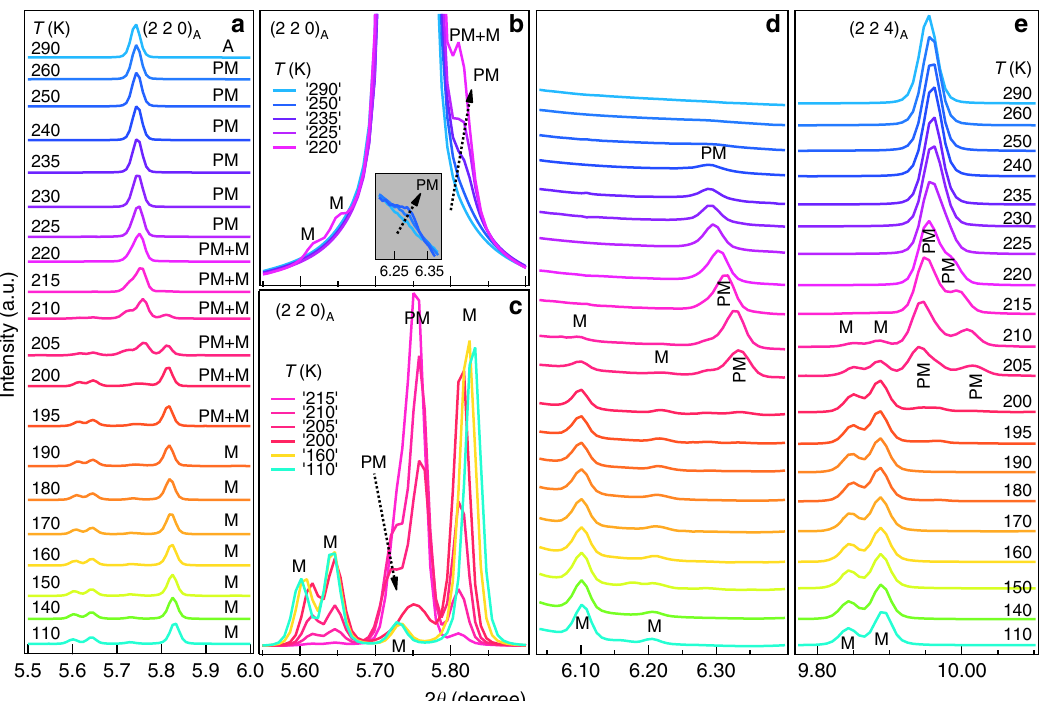
Fig. 2 Temperature-dependent synchrotron X-ray powder diffraction patterns. Evolution of synchrotron X-ray powder diffraction patterns of Ni 1.9 Pt 0.1 MnGa as a function of temperature during a cooling cycle for 3 selected 2 θ ranges. The (220) austenite peak region is shown in a , the satellite region in d , and the (224) austenite peak region in e . b , c represent the (220) austenite peak region with an expanded scale for selected temperatures. A, PM, and M represent the Bragg peaks of the cubic austenite, premartensite, and martensite phases, respectively. The inset in b shows the Bragg re fl ections at the extended scale in the 2 θ range between 6.20 and 6.38 where the satellite re fl ection of 3 M modulated premartensite phase is